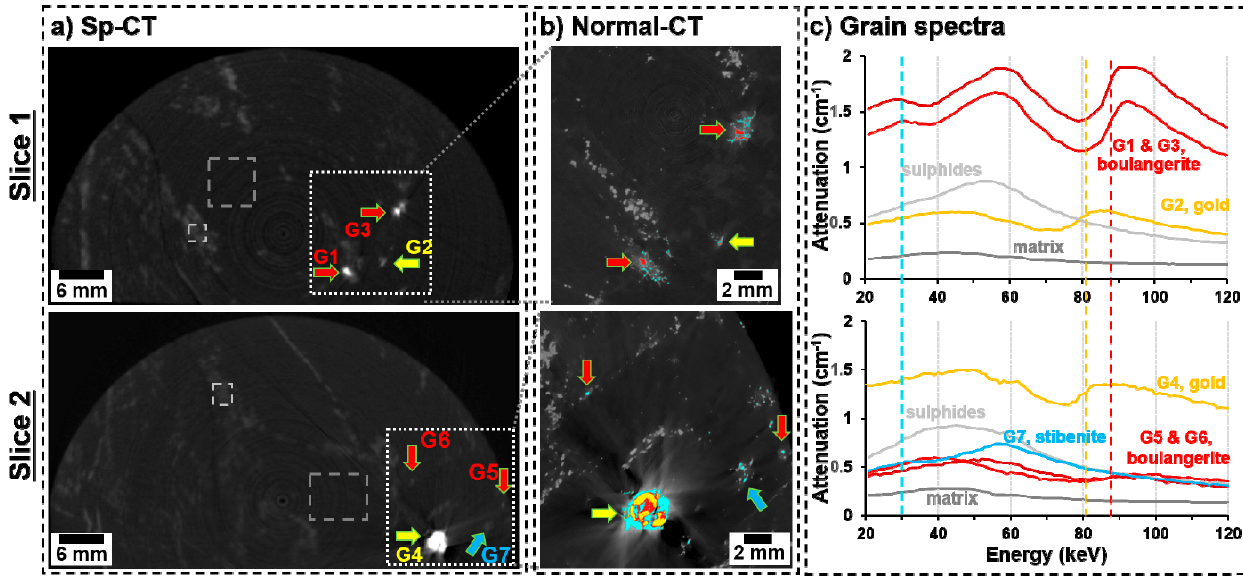
Figure 5. Classification of individual grains (G1–G7) in sp-CT images ( a ), using the grey-scale from traditional CT ( b ), and using the spectra from individual grains obtained with sp-CT ( c ) on two different slices (experiment 2). The colour scale is based on the total attenuation. The slice of normal CT shown corresponds to the region of interest shown as a dotted box.